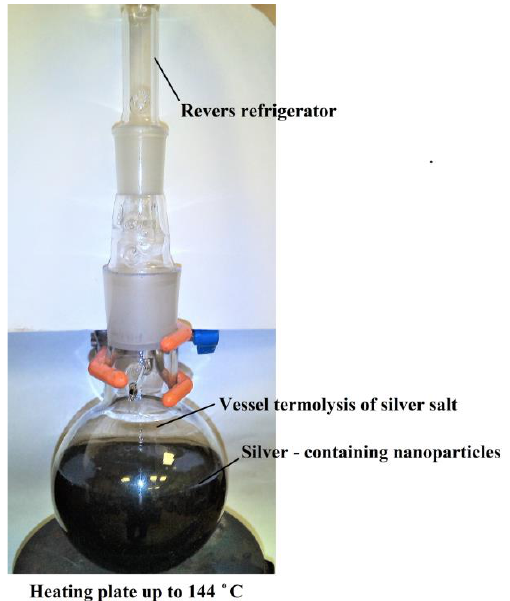
Figure 1. Image of the setup for the thermolysis of silver maleate in xylene.